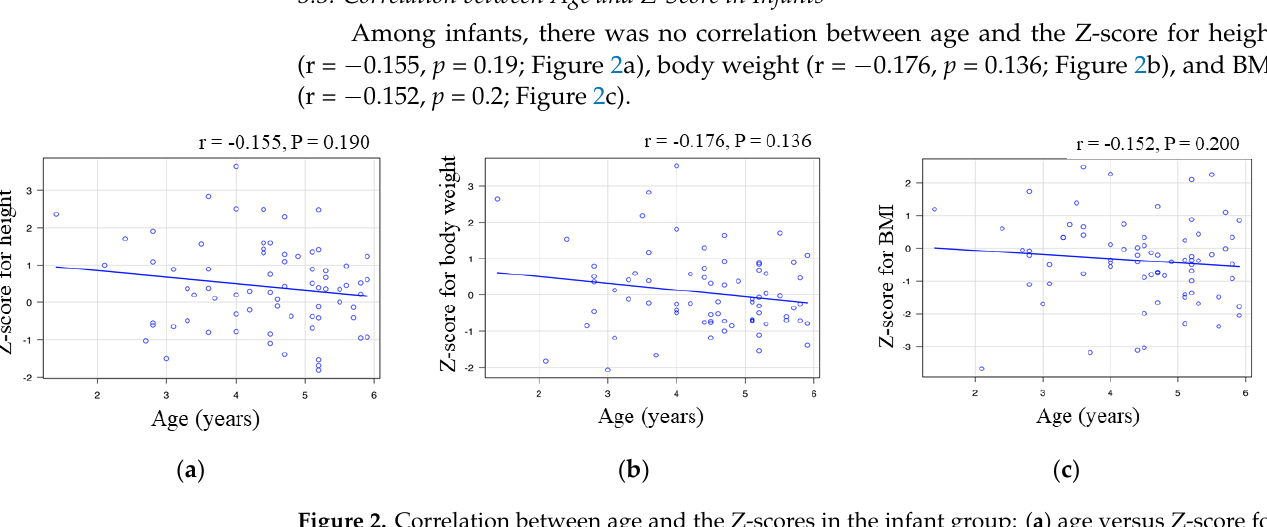
Figure 1. Comparison of Z-scores between the infant and school-age groups: (a) Z-score for height and (b) Z-score for body weight. The box plots show the interquartile range as well as the maximum and minimum values.